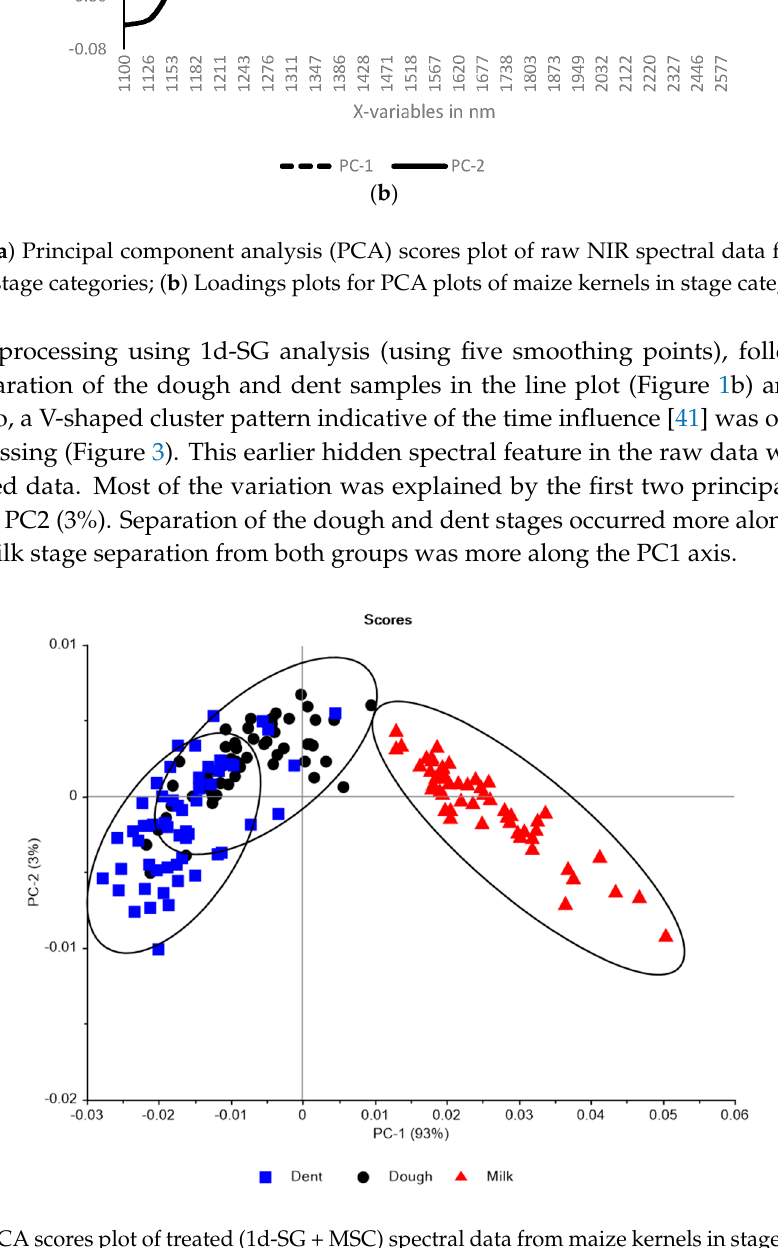
Figure 3. PCA scores plot of treated (1d-SG + MSC) spectral data from maize kernels in stage categories.